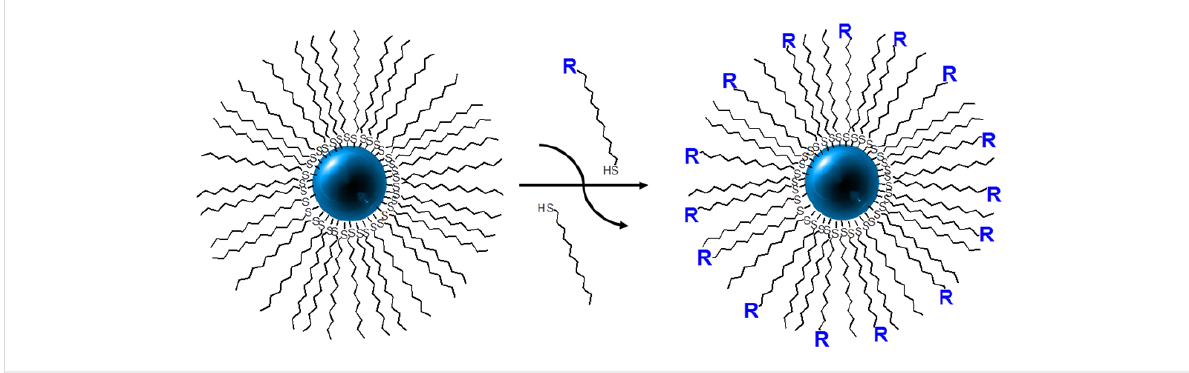
Figure 2: Schematic representation of the solvent-mediated ligand exchange process, illustrated for the partial exchange of thiols at the surface of a noble-metal nanoparticle; R represents a proto-mesogenic moiety.